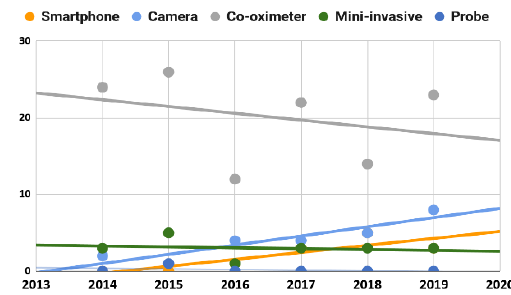
Figure 13. Region of Interest over Years.